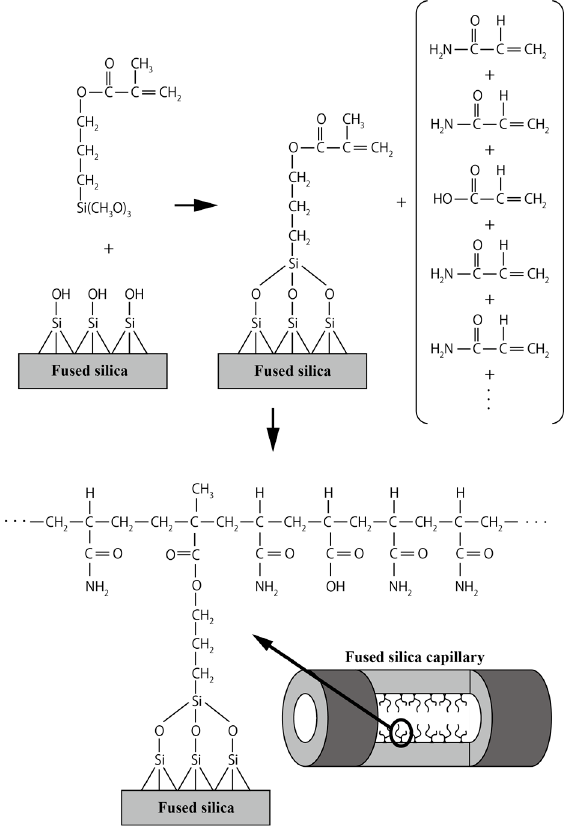
Figure 2. Schematic illustration of the coating procedure.